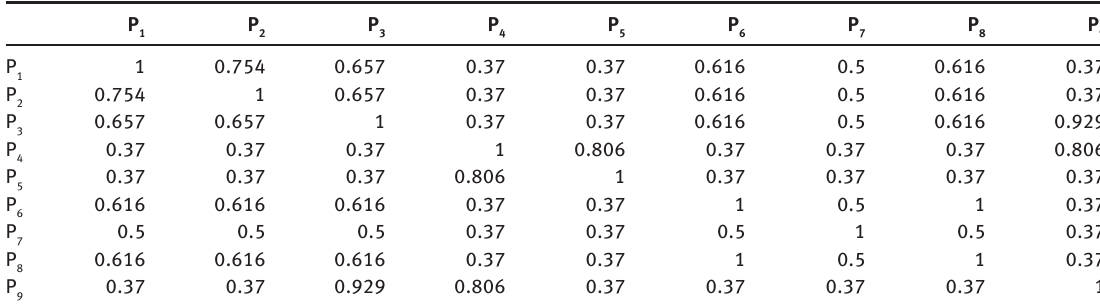
Table 4: Classification of Patients: Fuzzy Equivalence Relation Obtained Using the Cosine Amplitude Method (Nine Patients, Eight Symptoms).